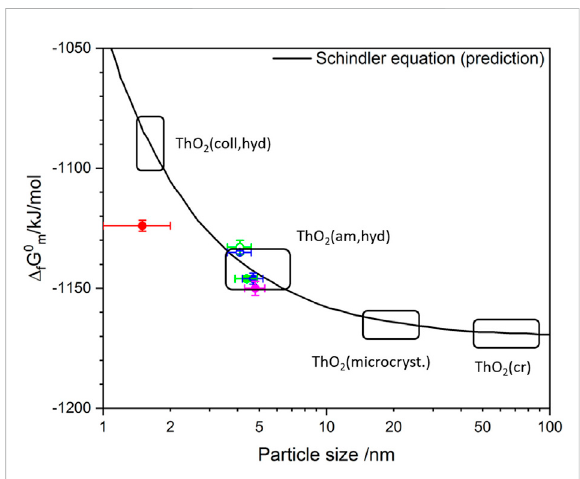
FIGURE 6 Application of Schindler equation to the ThO 2 (s) system and comparison with experimental data determined in the present work. Figure modi fi ed from (Neck et al.,